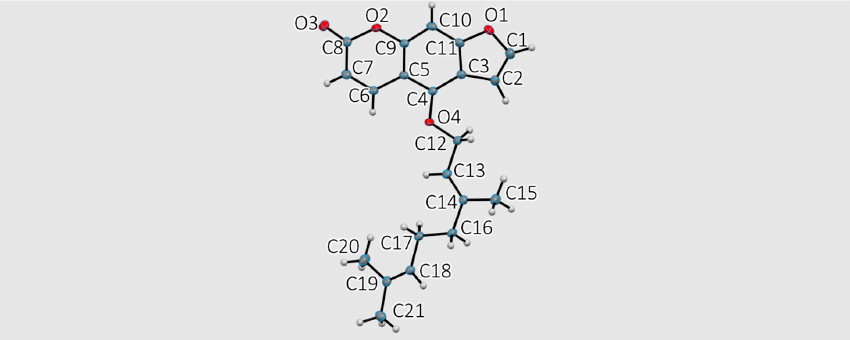
Figure 1. Labeling and bergamottin asymmetric unit in the crystal structure.